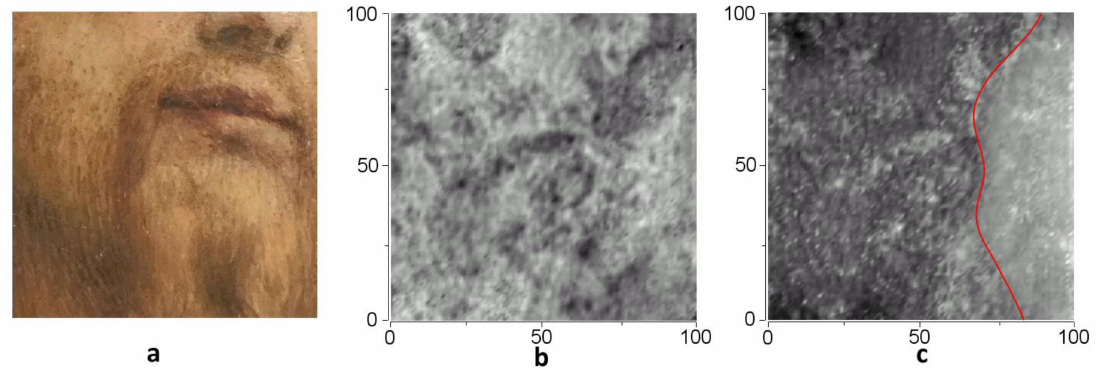
Figure 17. Visible ( a ) and THz images of the same area, taken at d = 0.5 mm ( b ) and d = 0.7 mm ( c ). In ( c ), the area on the left side of the red curve shows large variations, while the area on the right side exhibits smaller ones. Size of the images: 100 × 100 mm 2 .